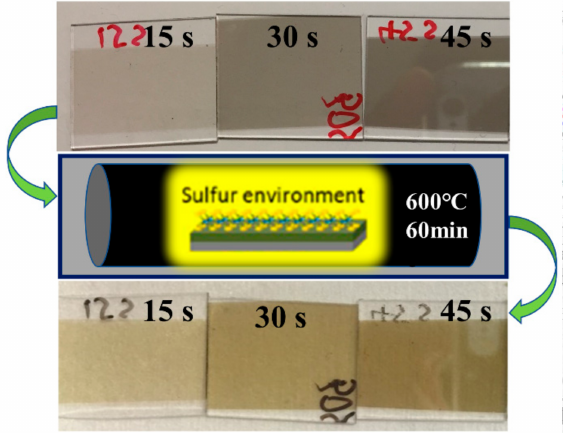
Figure 1. This post-deposition annealing treatment was performed to further enhance crystalline quality in as-sputtered MoS 2 on glass substrates under sulfur